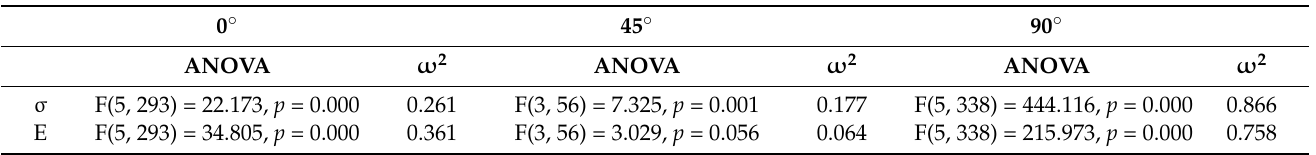
Table 3. The results of one-way ANOVA performed in SPSS 24.0 on the different load angles and different thicknesses as well as effect size ( ω 2 ) based on Hays